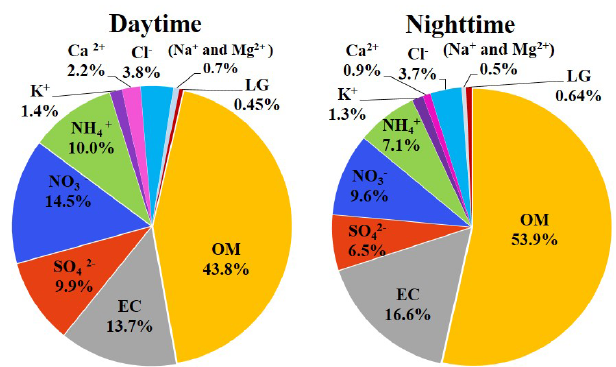
Figure 3. Percent contributions of individual component mass con- centrations to total estimated PM 2.5-cal mass for daytime and night- time during the sampling